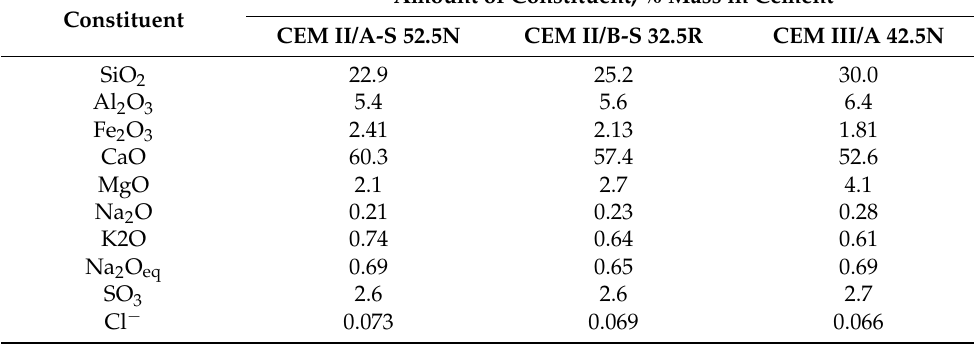
Table 1. Slag cement composition.